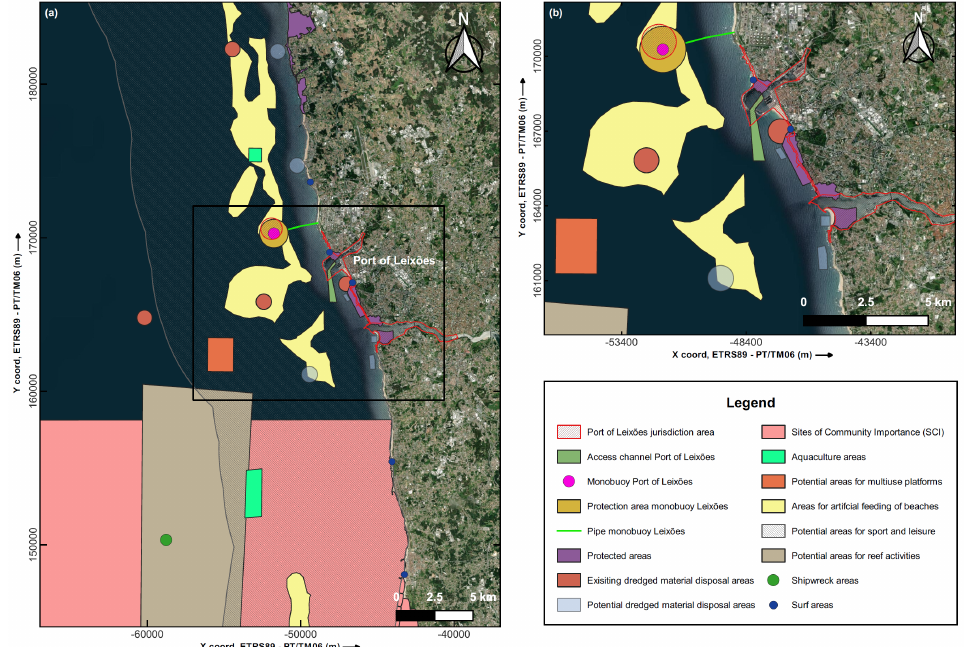
Figure 4. Marine uses in the surrounding areas of Port of Leixões